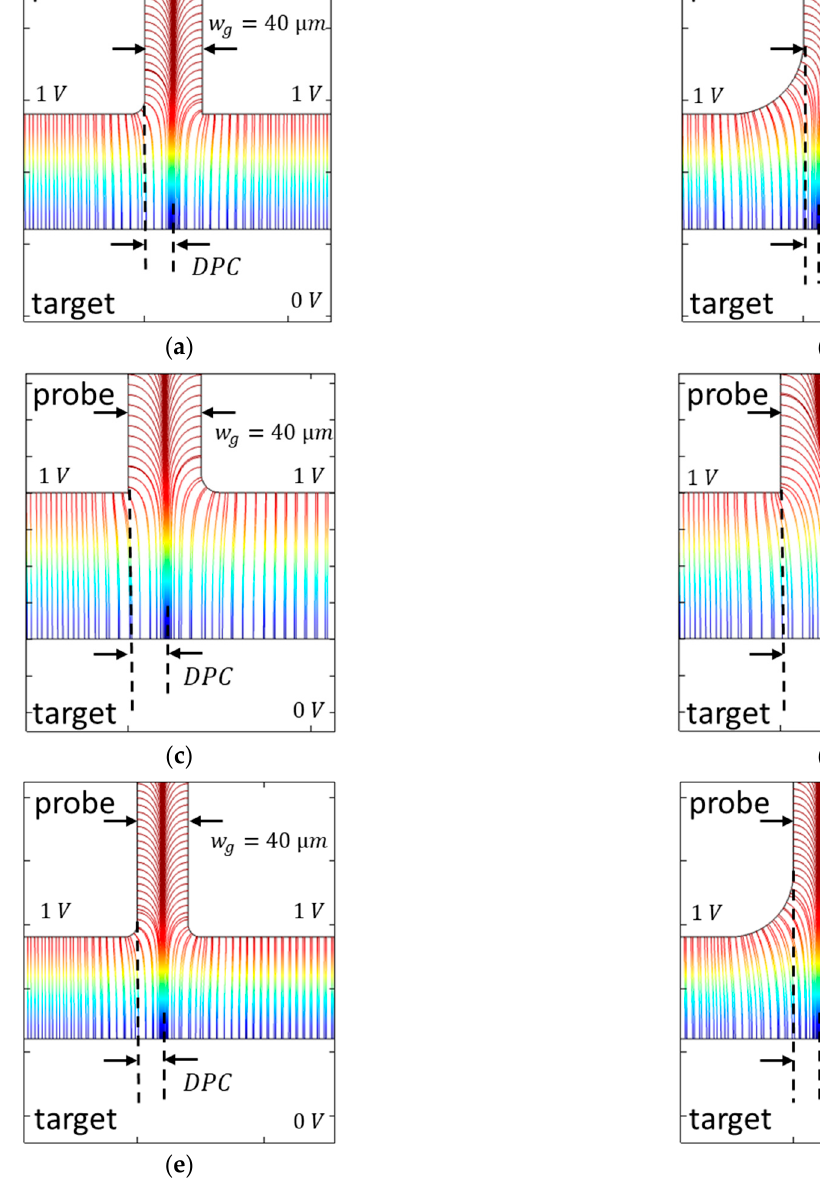
Figure 15. Comparison of the propagation of the electric field lines in the gap between the probe and its guard ring for different edge radii. Three scenarios are presented: ( a , b ) the edge radius of the probe electrode is varied; ( c , d ) the edge radius of the guard ring of the probe electrode is varied; ( e , f ) the edge radius of the probe electrode and the edge radius of its guard ring are both varied. Depending on the edge radius, the field lines are distorted differently. This changes the DPC. Furthermore, in the first and third case, the geometric surface of the probe changes as well.